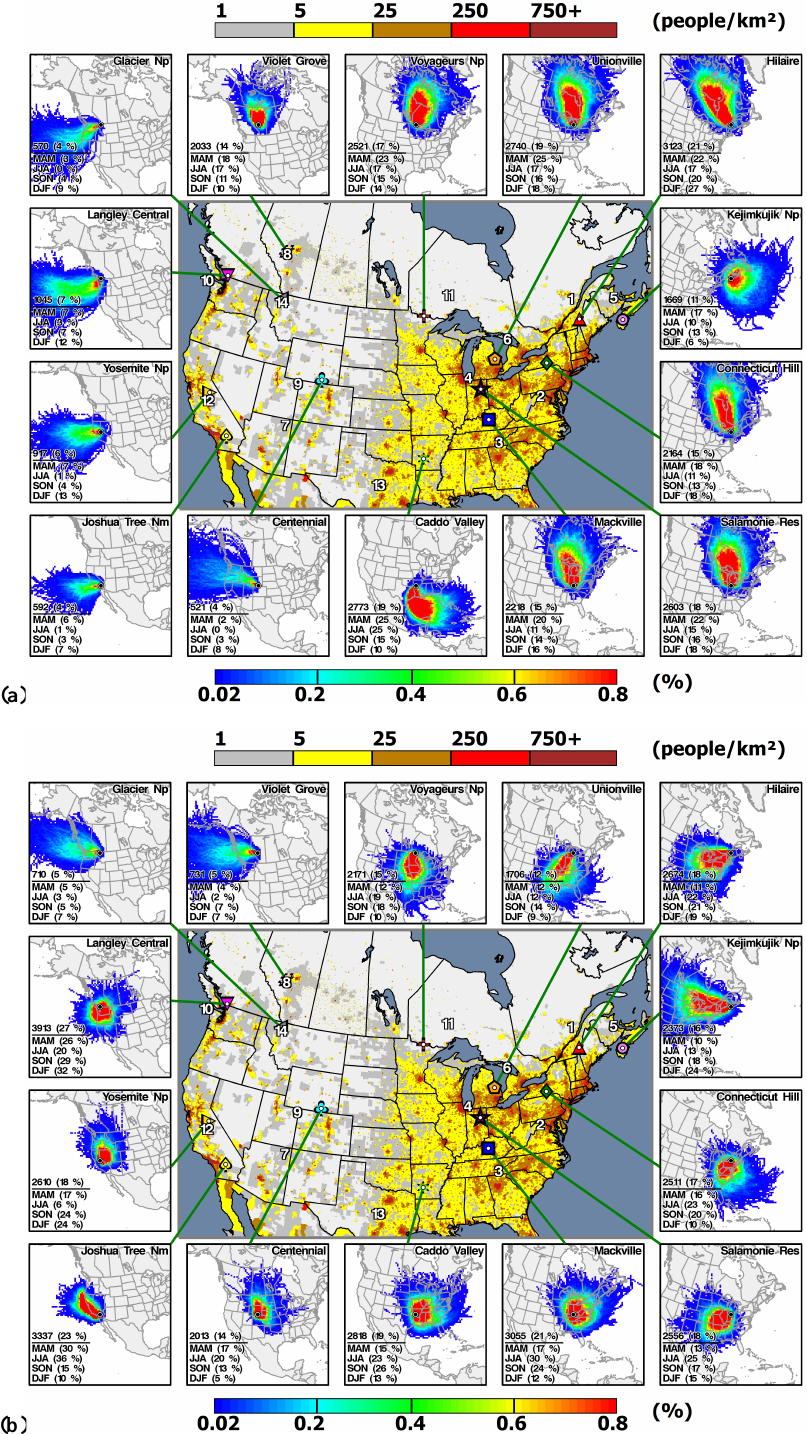
Fig. 4. (a) Probability densities of air parcel trajectory clusters ( baseline air) associated with the lowest May–September 95th percentile ozone mixing ratios for 14 statistically representative sites (out of 97 in total) for the years 1997–2006 combined. The total number of trajectories for the cluster and the transport frequency (in bracket, %) is shown above the horizontal bar. The relative seasonal transport frequencies (relative to other five clusters) are shown below the bar (other five clusters not shown). Population data were taken from CIESIN (2005). (b) Probability densities of air parcel trajectory clusters ( most polluted air) associated with the highest May–September 95th percentile ozone mixing ratios for 14 statistically representative sites (out of 97 in total) for the years